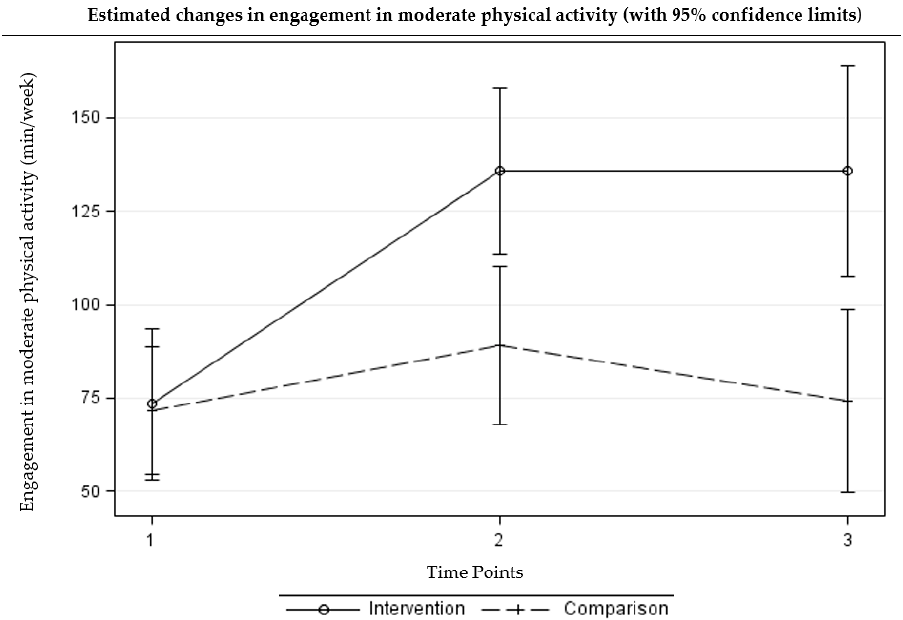
Figure 4. Estimated changes over time in engagement in moderate physical activities among intervention and comparison groups. (Time points: 1 = baseline, 2 = three ‐ month follow ‐ up, and 3 = six ‐ month follow ‐ up) (Multi ‐ level multivariable mixed ‐ effects linear model).